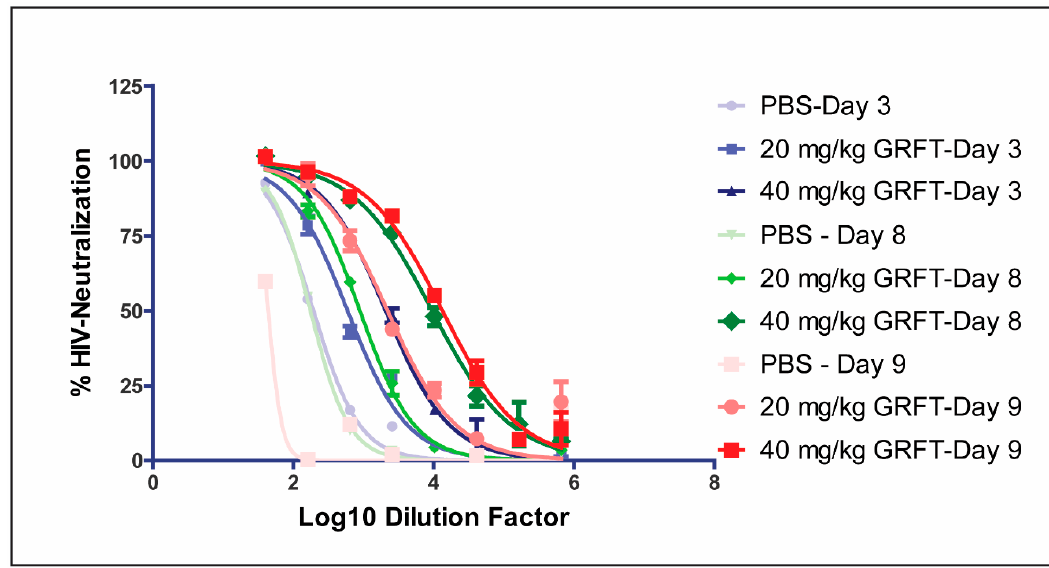
Figure 3. Antiviral activity of pooled fecal extracts collected during chronic oral treatment with GRFT. HIV-1 env-pseudovirus neutralization activity was assessed in pooled rat fecal extracts from animals dosed with 20 or 40 mg/kg GRFT, and expressed as ID 50 (dilution factor required to reduce luminescence to 50% of PBS treated controls). Table 2. Antiviral activity of pooled fecal extracts collected during chronic oral treatment with GRFT. Day Treatment Fecal GRFT (ng/mL)